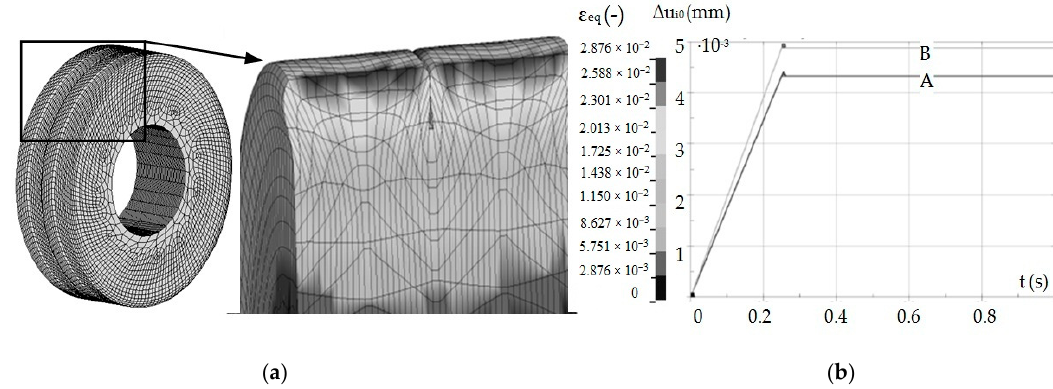
Figure 10. Geometric model with a mesh of finite elements and mesh deformation ( a ), elastic return of selected inequality nodes with variable geometry—A and constant—B ( b ).